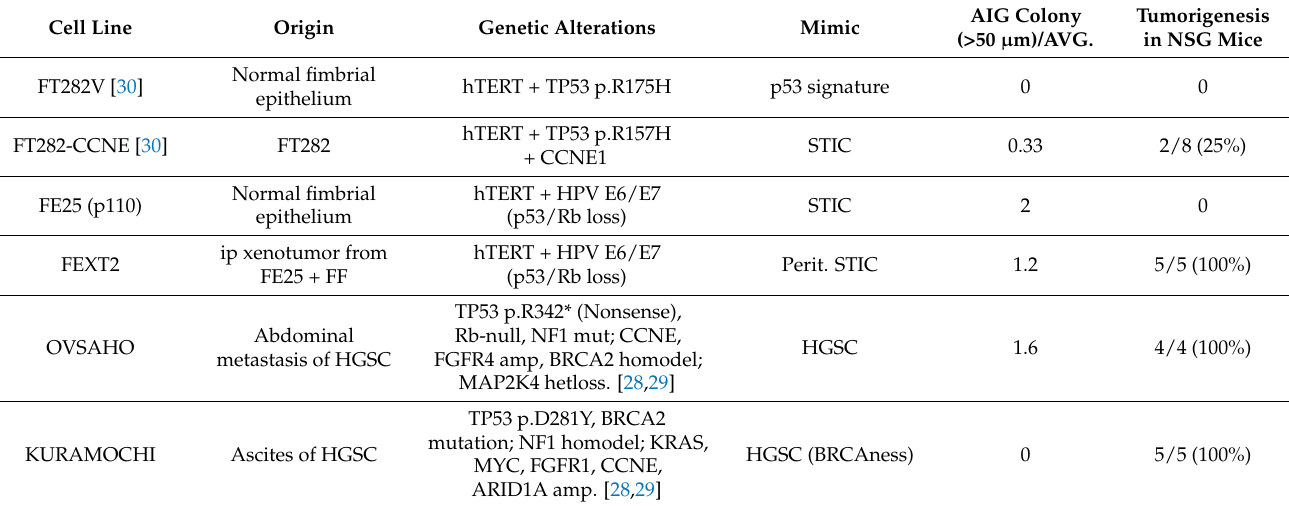
Table 1. Immortalized human fimbrial epithelial cell lines and HGSC cell